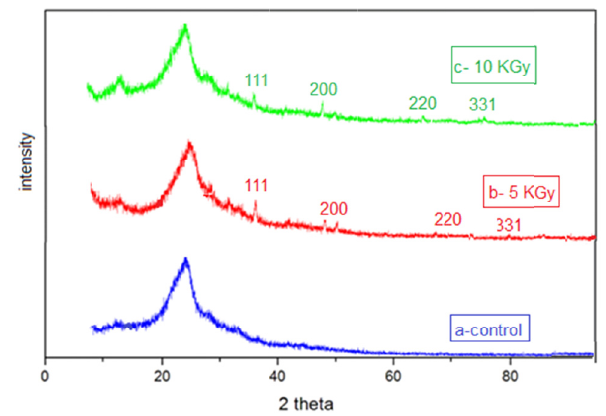
Fig. 5. XRD patterns of untreated (a) and AgNPs-treated silk fabric with different gamma irradiation doses (b and c).